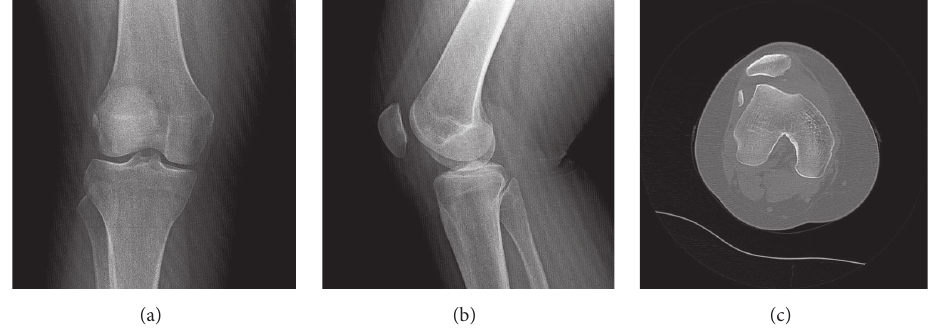
Figure 1: Preoperative anteroposterior (a) and lateral (b) X-rays and axial computed tomography (CT) (c) of the right knee show the free fragment and osteochondral defect.